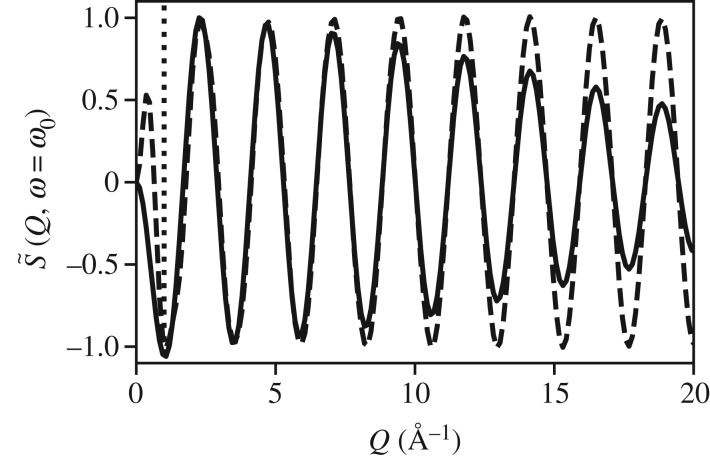
Comparison of the classical theory for S~(Q,ω=ω0) (dashed line) and the quantum mechanical model for the same system (solid line). We observe that the classical model has an artefact below 1 Å−1 due to the Dirac delta representation. Otherwise the two models agree up to about 7 Å−1 at which point we begin to observe changes that can only be attributed to the amplitude of motion and fine structure of the wavepacket as shown in figure 10.